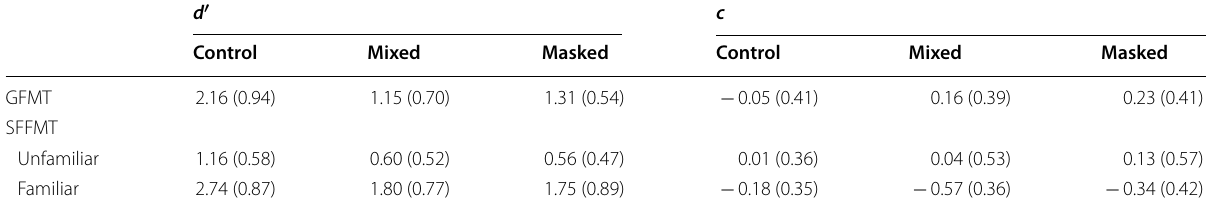
Table 1 Descriptive statistics [mean(SD)] for measures of human performance ( d ′ , c ) on the GFMT and the SFFMT d ′